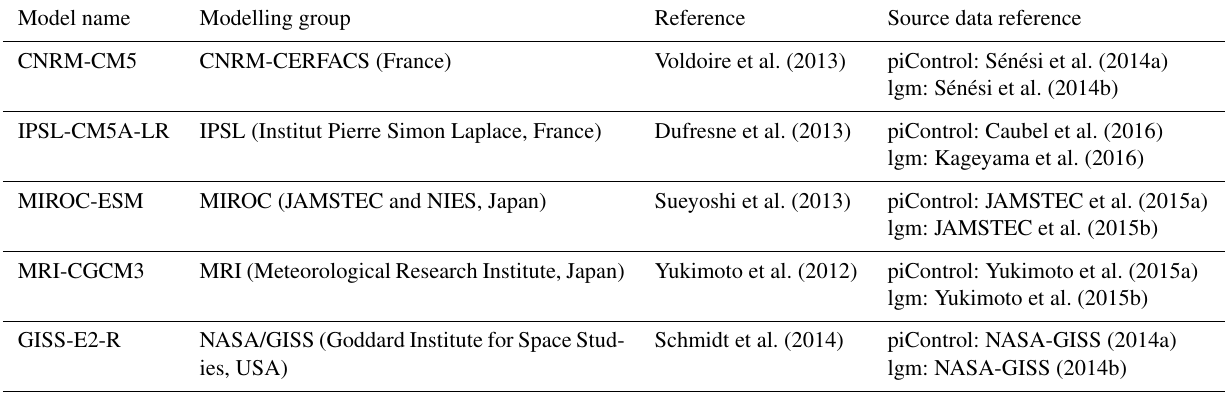
Table 2. PMIP3 models used in this study.